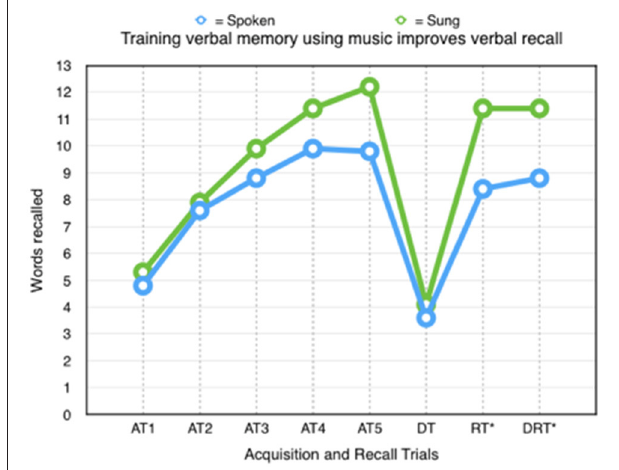
FIGURE 3 | Comparision of groups across trials. (AT, acquisition trials; DT, distractor trials; RT, retention trial; DRT, delayed recall trial; *Statistically significant